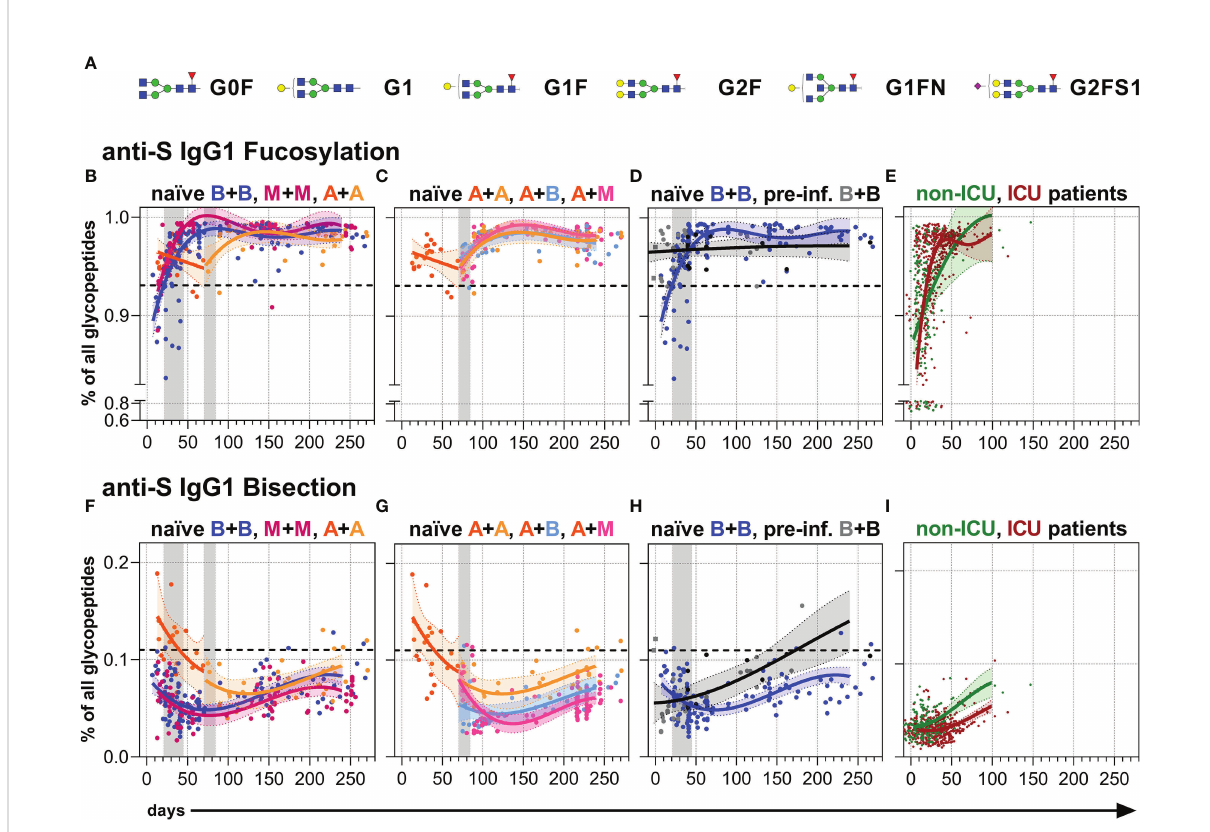
FIGURE 4 Anti-S serum IgG1 fucosylation and bisection. (A) The six major IgG Fc N -glycans attached to Asn 297 of IgG1 with an average relative abundance of more than 3% (Table S2): Galactose: G, yellow circle; sialic acid: S, purple diamond; fucose: F, red triangle; mannose: green circle; N-acetylglucosamine: GlcNAc and bisecting GlcNAc, N, blue square. (B – D) Anti-S serum IgG1 Fc N -fucosylation and (F – H) anti-S serum IgG1 Fc N -bisection of the indicated six vaccination groups. The used color codes are identical to Figure 1D. Gray bars: time windows of the second shot after the fi rst shot with an mRNA (between day 21 and 45) or adenovirus-based (between day 70 and 84) vaccine. Dashed lines indicate the average level of total IgG1 Fc fucosylation or bisection, respectively (Figure S6). (E) Anti-S serum IgG1 Fc N -fucosylation and (I) anti-S serum IgG1 Fc N -bisection of unvaccinated, hospitalized non-ICU and ICU SARS-CoV-2 patients from our previous study (60) for